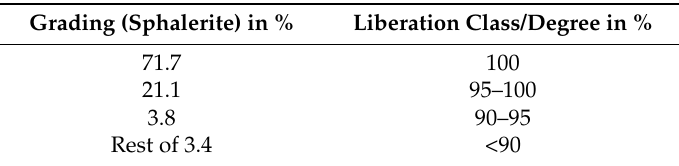
Table 8. Mineral liberation degree by particle composition based on MLA data for sphalerite of the sample A1-SM.